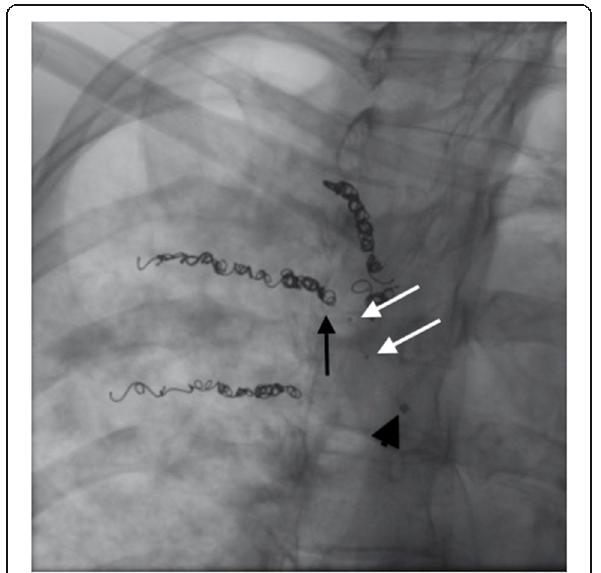
Fig. 3 Magnified slight RAO fluoroscopic image demonstrating an uninflated 4 × 11 mm Scepter XC balloon catheter with its tip (black arrow) within the interstices of the coil mass. White arrows point to the proximal and distal radio-opaque markers showing the location of the uninflated balloon of the Scepter XC balloon catheter. The black arrowhead shows the radio-opaque distal tip of the Neuron 6F 053 Delivery Catheter® (Penumbra, USA)